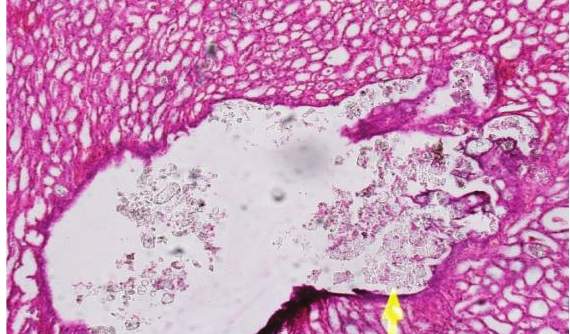
Fig-2B: Tubule dilated with crystal clusters (group 2) under 20X